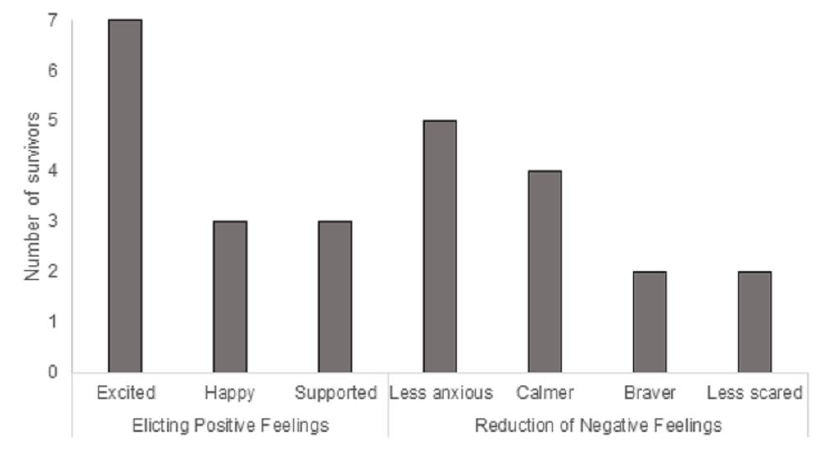
Figure 2. Survivors’ feelings relating to the presence of the facility dog.